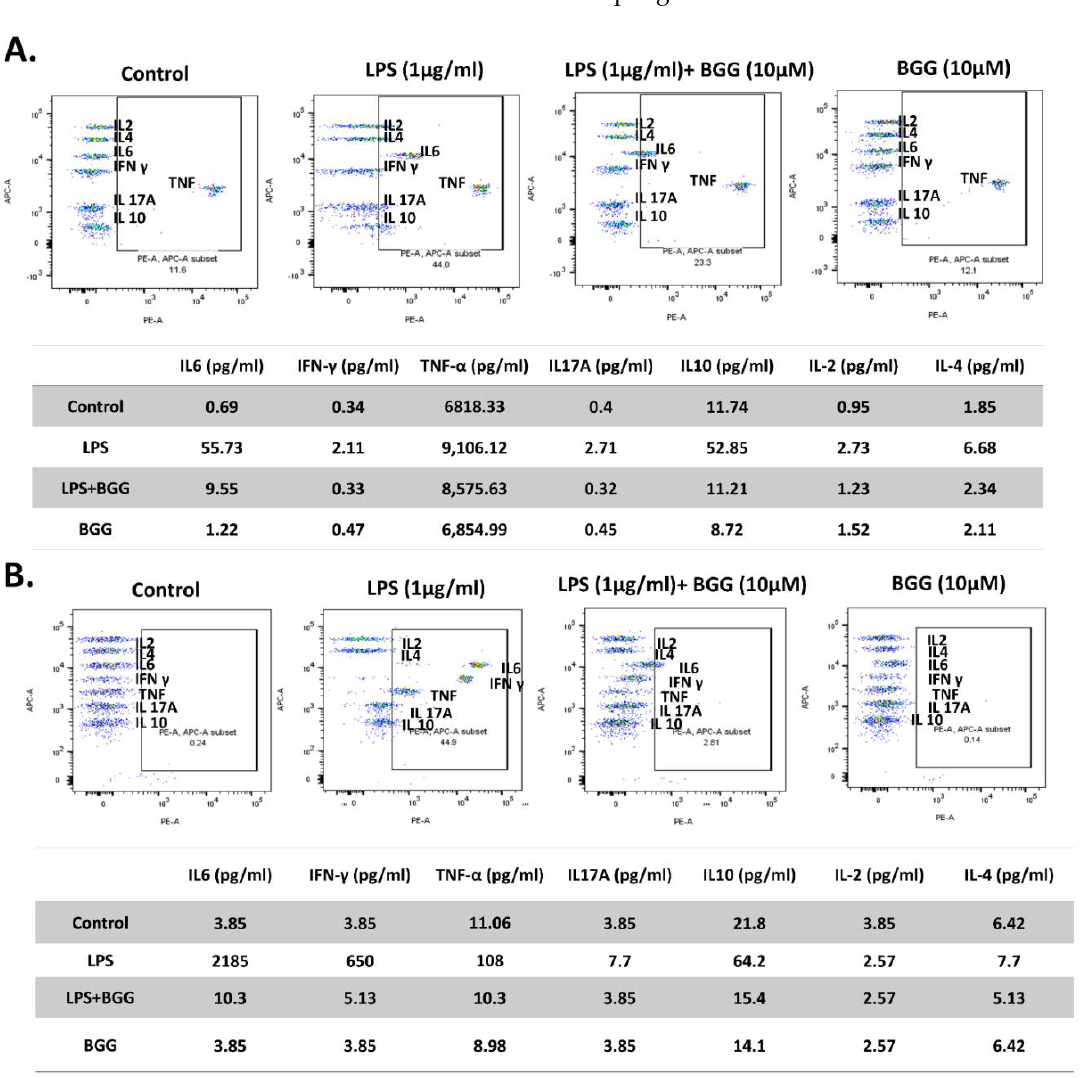
Figure 9. Measuring extracellular cytokine interleukins by CBA bead assay analyzed by using flow cytometry in ( A ) RAW 264.7 and ( B ) mice peritoneal